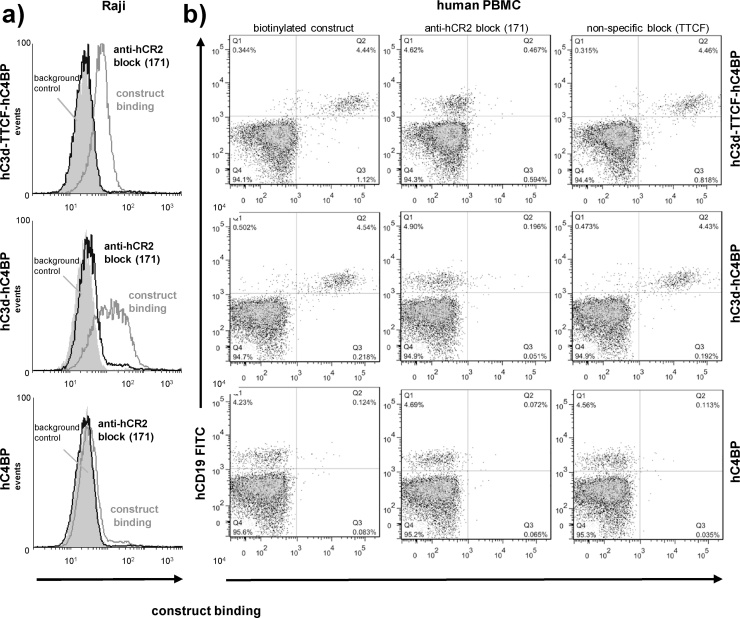
hC3d-containing constructs bind to B cells via hCR2.a) Raji cells were incubated with mAb 171 (hCR2 block, black line) or buffer alone (dark grey line) followed by hC3d-TTCF-hC4BP, hC3d-hC4BP and hC4BP. Bound constructs were detected with sheep anti-hC4BP followed by PE conjugated donkey anti-sheep IgG. The filled light grey histogram indicates the level of background staining from the sheep anti-C4BP plus secondary on cells treated with mAb 171 (but no construct) indicating no cross-reactivity of the secondary with the block (b). Isolated human PBMC cells from healthy volunteers (n = 4) were stained with anti-hCD19-FITC to label B cells and were incubated with PBS (left column), mAb 171 (middle column), or TTCF (right column) prior to incubation with biotinylated hC3d-TTCF-hC4BP, hC3d-hC4BP and hC4BP followed by SA-APC. 10,000 events were collected and results are representative of several experiments.